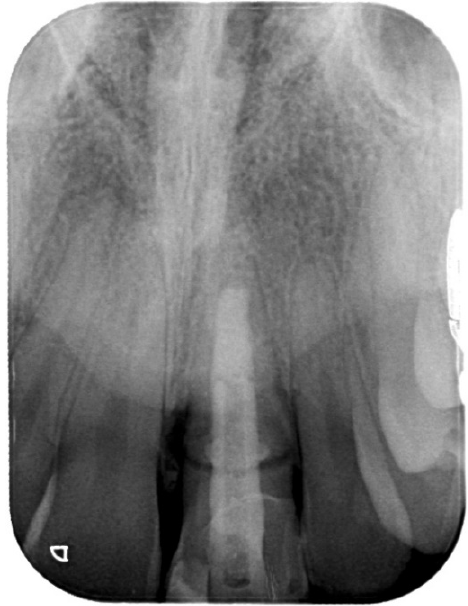
Figure 4. Preclinical intraoral picture after the second trauma, palatal view.